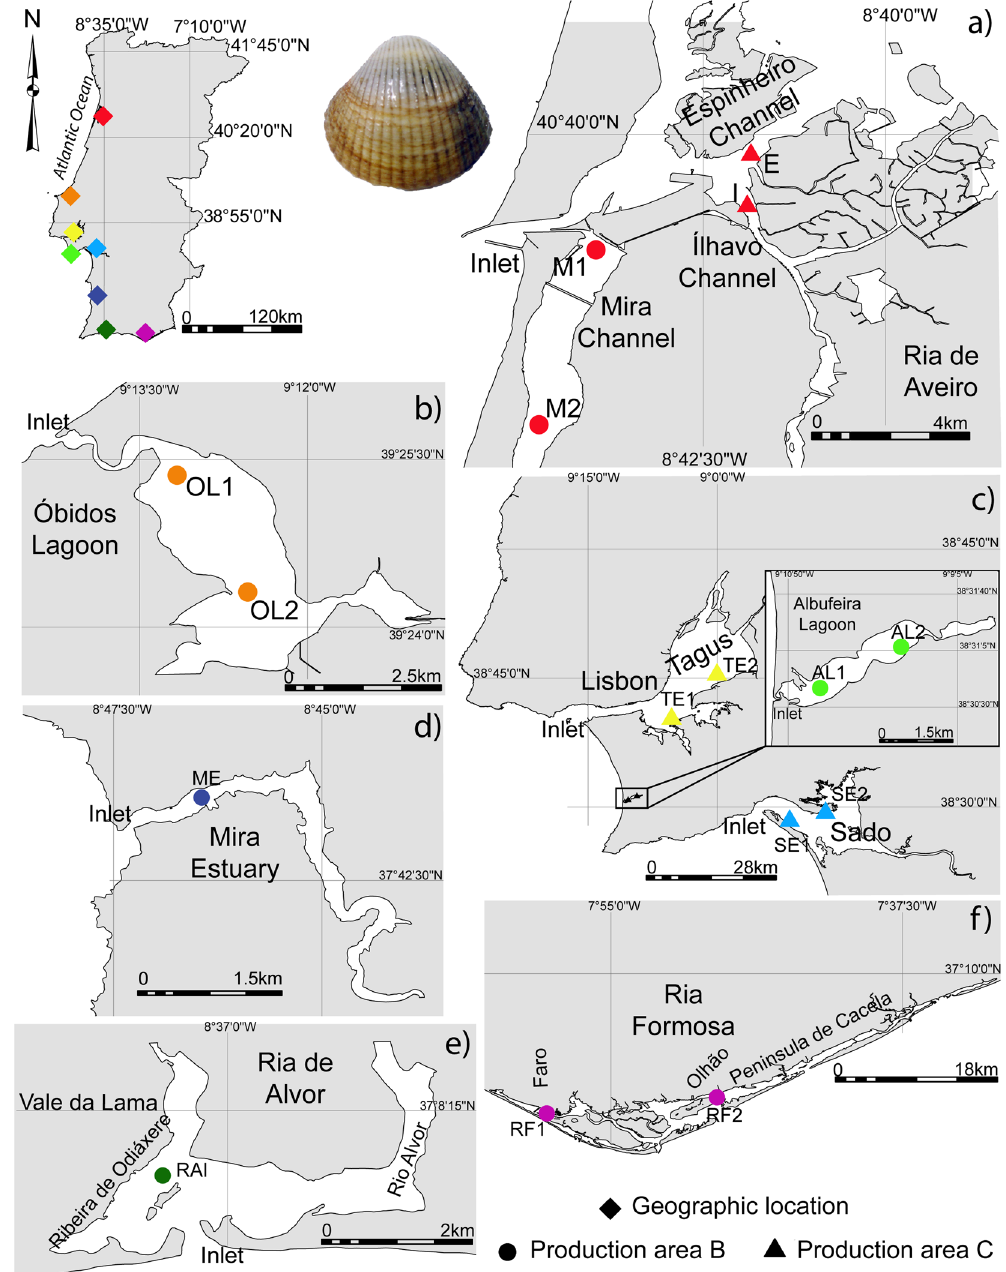
Figure 1. Sampling locations of Cerastoderma edule in mainland Portugal: ( a ) Ria de Aveiro (RAv; M1:40°38 ′ 26.30 ″ N, 8°43 ′ 58.90 ″ W; M2: 40°35 ′ 58.30 ″ N, 8°44 ′ 47.80 ″ W; I: 40°38 ′ 35.40 ″ N, 8°41 ′ 35.40 ″ W and E: 40°39 ′′ 48.50 ″ N, 8°41 ′ 45.03 ″ W), ( b ) Óbidos lagoon (OL1: 39°25 ′ 20.34 ″ N, 9°13 ′ 14.54 ″ W and OL2: 39°24 ′ 2.01 ″ N, 9°12 ′ 30.91 ″ W), ( c ) Tagus estuary (TE1: 38°39 ′ 27.44 ″ N, 9°6 ′ 35.95 ″ W and TE2: 38°44 ′ 5.18 ″ N, 9°0 ′ 46.54 ″ W), Albufeira lagoon (AL1: 38°30 ′ 36.67 ″ N, 9°10 ′ 32.96 ″ W and AL2: 38°31 ′ 1.33 ″ N, 9°9 ′ 53.16 ″ W) and Sado estuary (SE1: 38°27 ′ 46.00 ″ N, 8°51 ′ 32.00 ″ W and SE2: 38°29 ′ 13.25 ″ N, 8°48'52.79 ″ W) ( d ) Mira estuary (ME: 37°43 ′ 30.60 ″ N, 8°46 ′ 15.40 ″ W), ( e ) Ria de Alvor (RAl: 37°07 ′ 55.7 ″ N, 8°37 ′ 27.40 ″ W) and ( f ) Ria Formosa (RF1: 37°00'23.20 ″ N, 7°59 ′ 28.40 ″ W and 37°01'24.30 ″ N, 7°49 ′ 49.50 ″ W). The map was created using the software ArcGIS